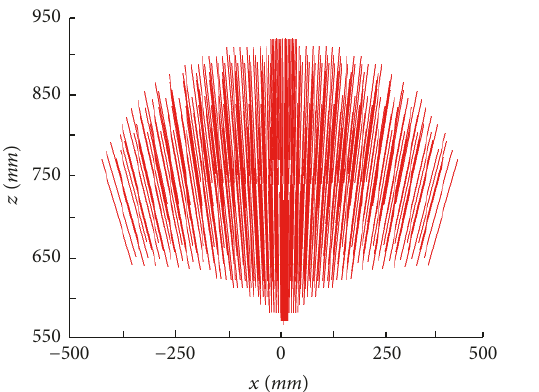
Figure 8: The workspace of the mechanism in 𝑥 − 𝑧 .